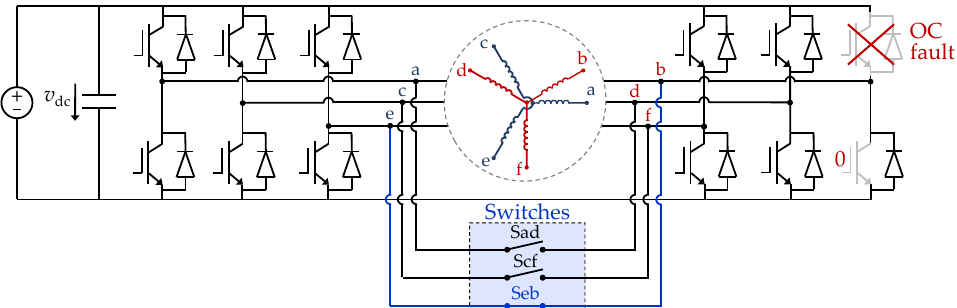
Figure 15. Topology with bidirectional switches so that a leg can be shared by two phases